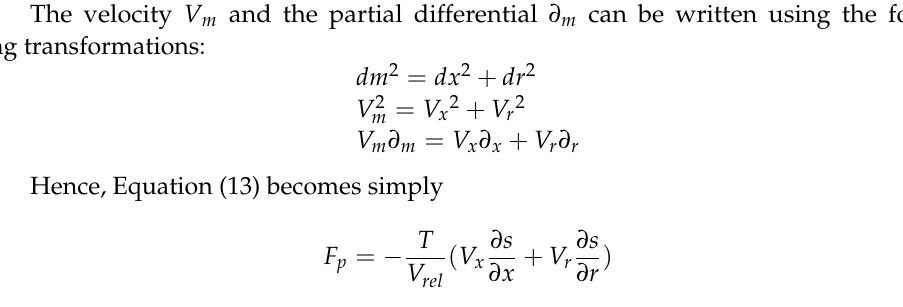
Figure 2. Schematic diagram of the meridional streamline.